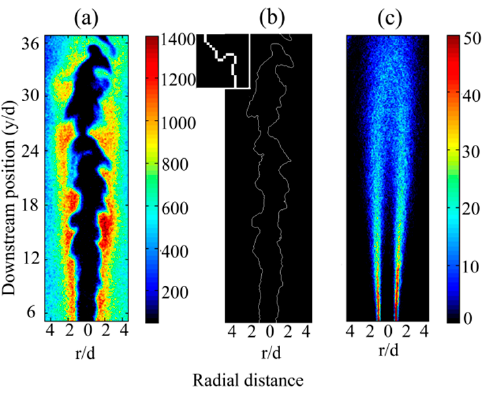
Figure 4. Analysis process of flame front surface: ( a ) instantaneous image of OH-PLIF; ( b ) flame front of the instantaneous image; ( c ) overlaying of 500 flame front boundaries.